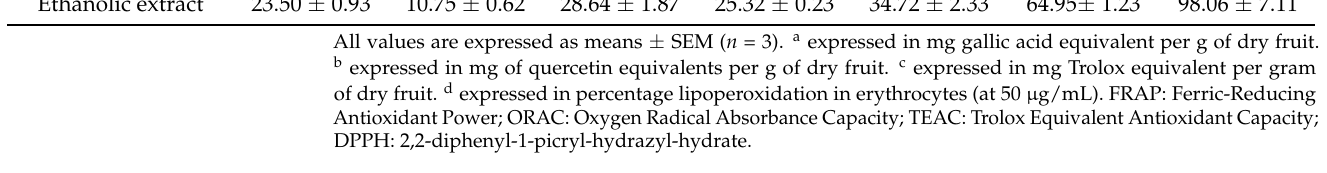
Table 3. Total phenolic and antioxidant activity of A. dentata ethanolic extract.